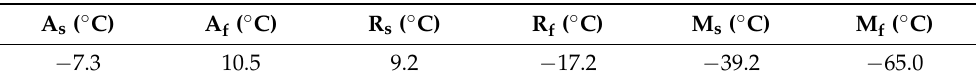
Table 2. Transformation temperatures of the modified NiTi alloy after sintering. A s —start temper- ature of the reverse martensitic transformation, A f —finish temperature of the reverse martensitic transformation, M s —start temperature of the forward martensitic transformation, M f —finish tem- perature of the forward martensitic transformation, R s —start temperature of the B2 → R transition, R f —finish temperature of the B2 → R transition, B2 → R → B19—martensitic transformation, B19 → B2— reverse martensitic